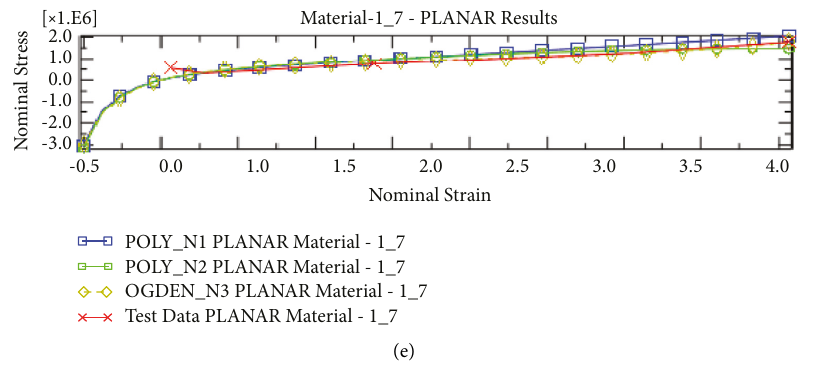
Figure 3: Composite lamina (a) and laminate (b). (c) Uniaxial tensile test date. (d) Test biaxial tensile test date. (e) Plane tensile test